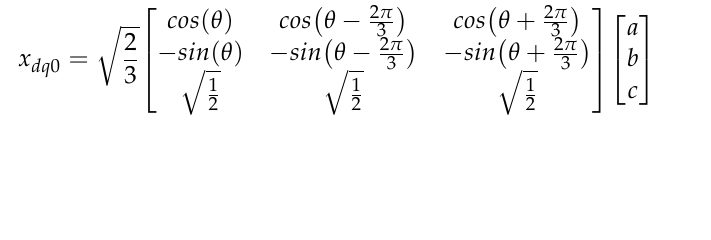
Figure 4. Rotor (i.e., DQ) Reference frame with current and flux vectors shown. The transformation from the stationary ABC reference frame to the rotating (synchronous) DQ reference frame is provided in Equation (1).